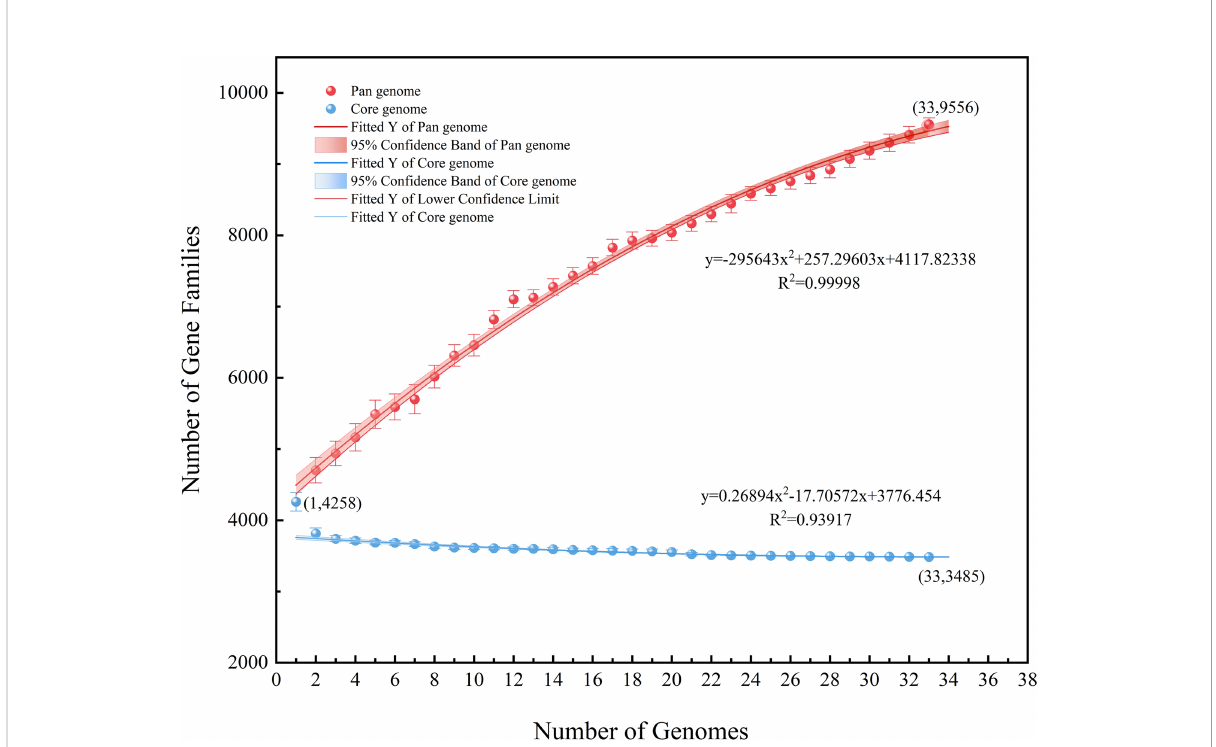
FIGURE 7 Pan-core genome analysis of 33 strains of A. hydrophila , except the two possibly misclassi fi ed strains (ANI<95%).